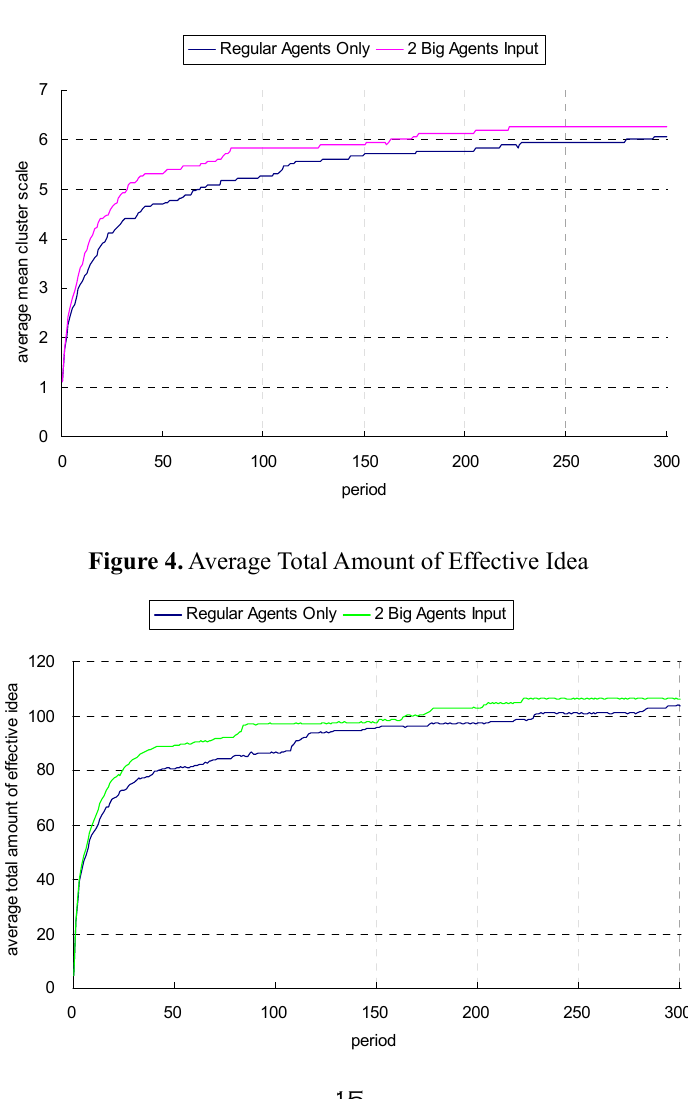
Figure 3. Average Mean Cluster Scale